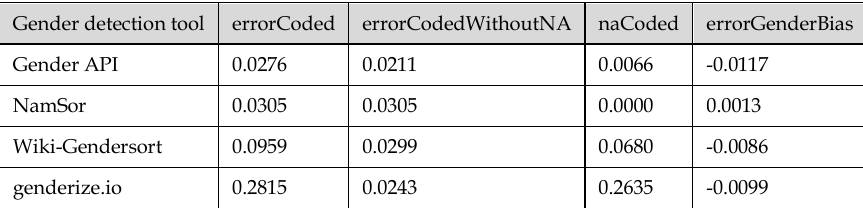
Table 5 Performance metrics for gender detection tools, after removing duplicates (i.e. physicians with identical first names and gender) (n=3,013